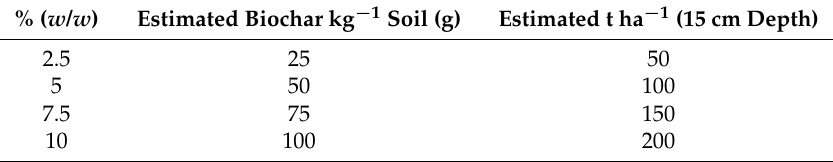
Table 1. The calculated application rates of biochar used in the incubation